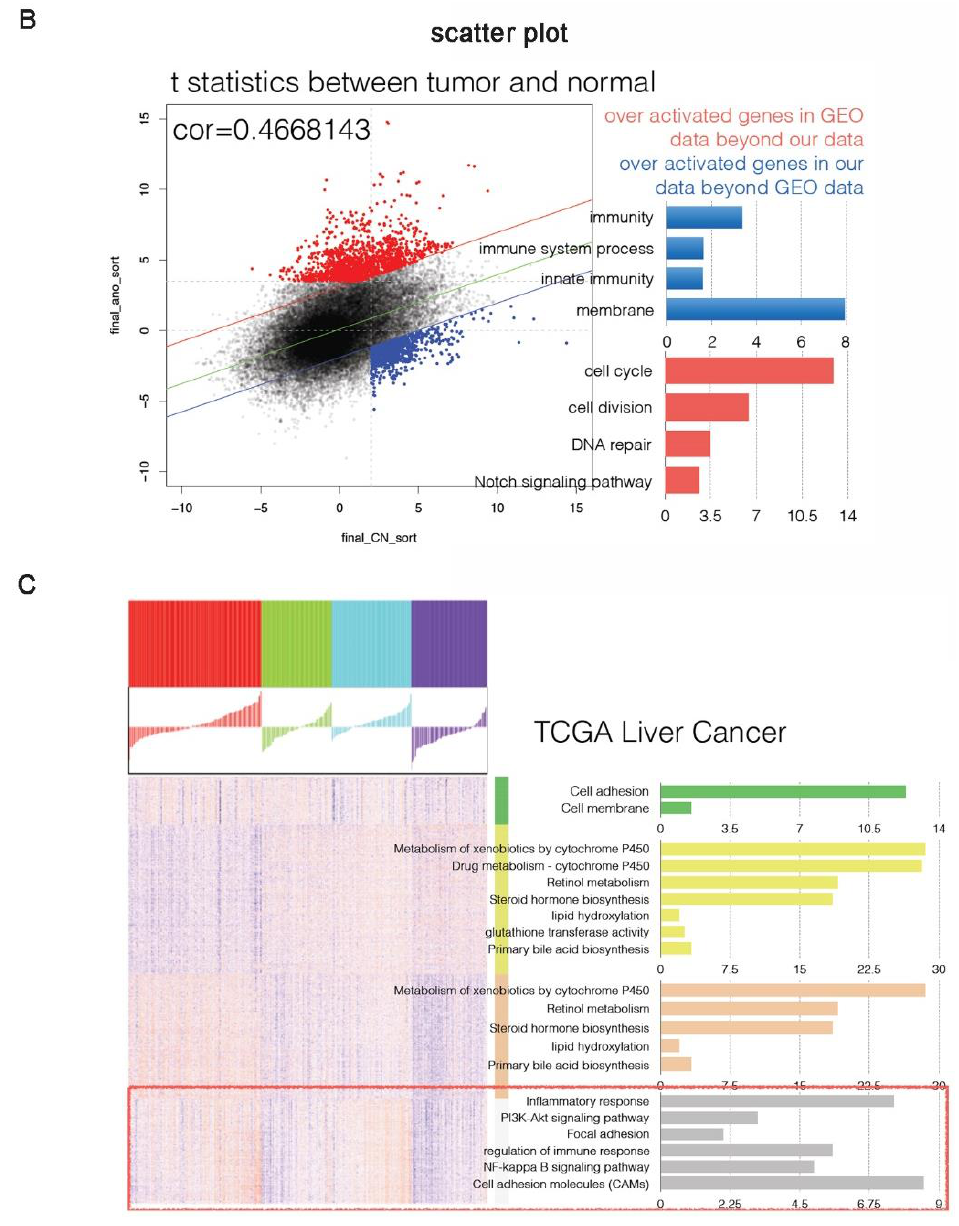
Figure 5. Comparison of HCC gene expression profiles between HSV-tk and Notch transgenic mice and the Cancer Genome Atlas (TCGA) data. ( A , B ) Gene set enrichment analysis (GSEA) comparing the up-regulated and down-regulated pathways of Notch and HSV-tk transgenic mice HCC. ( A ) Up-regulated and down-regulated pathways in Notch mice compared with HSV-tk mice. ( B ) HSV-tk mice immune-inflammation related signals were up-regulated compared to Notch mice. Increased expression of signals in Notch mice included cell cycle and DNA repair pathways. Over-activated genes in Notch mice beyond HSV-tk mice (red colors); Over-activated genes in HSV-tk mice beyond Notch mice (blue colors), respectively. ( C ) The change of pathways of human HCC in TCGA data. Immune-inflammatory reactions (red rectangle) in the human liver have high heterogeneity, are only highly expressed in some